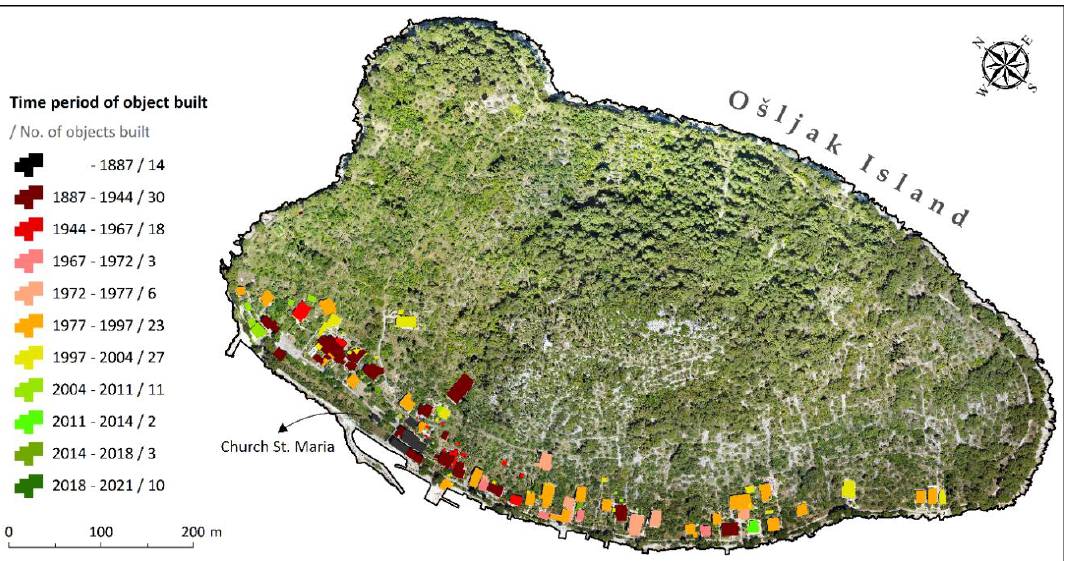
Figure 21. Number of residential and commercial objects built-in defined periods.